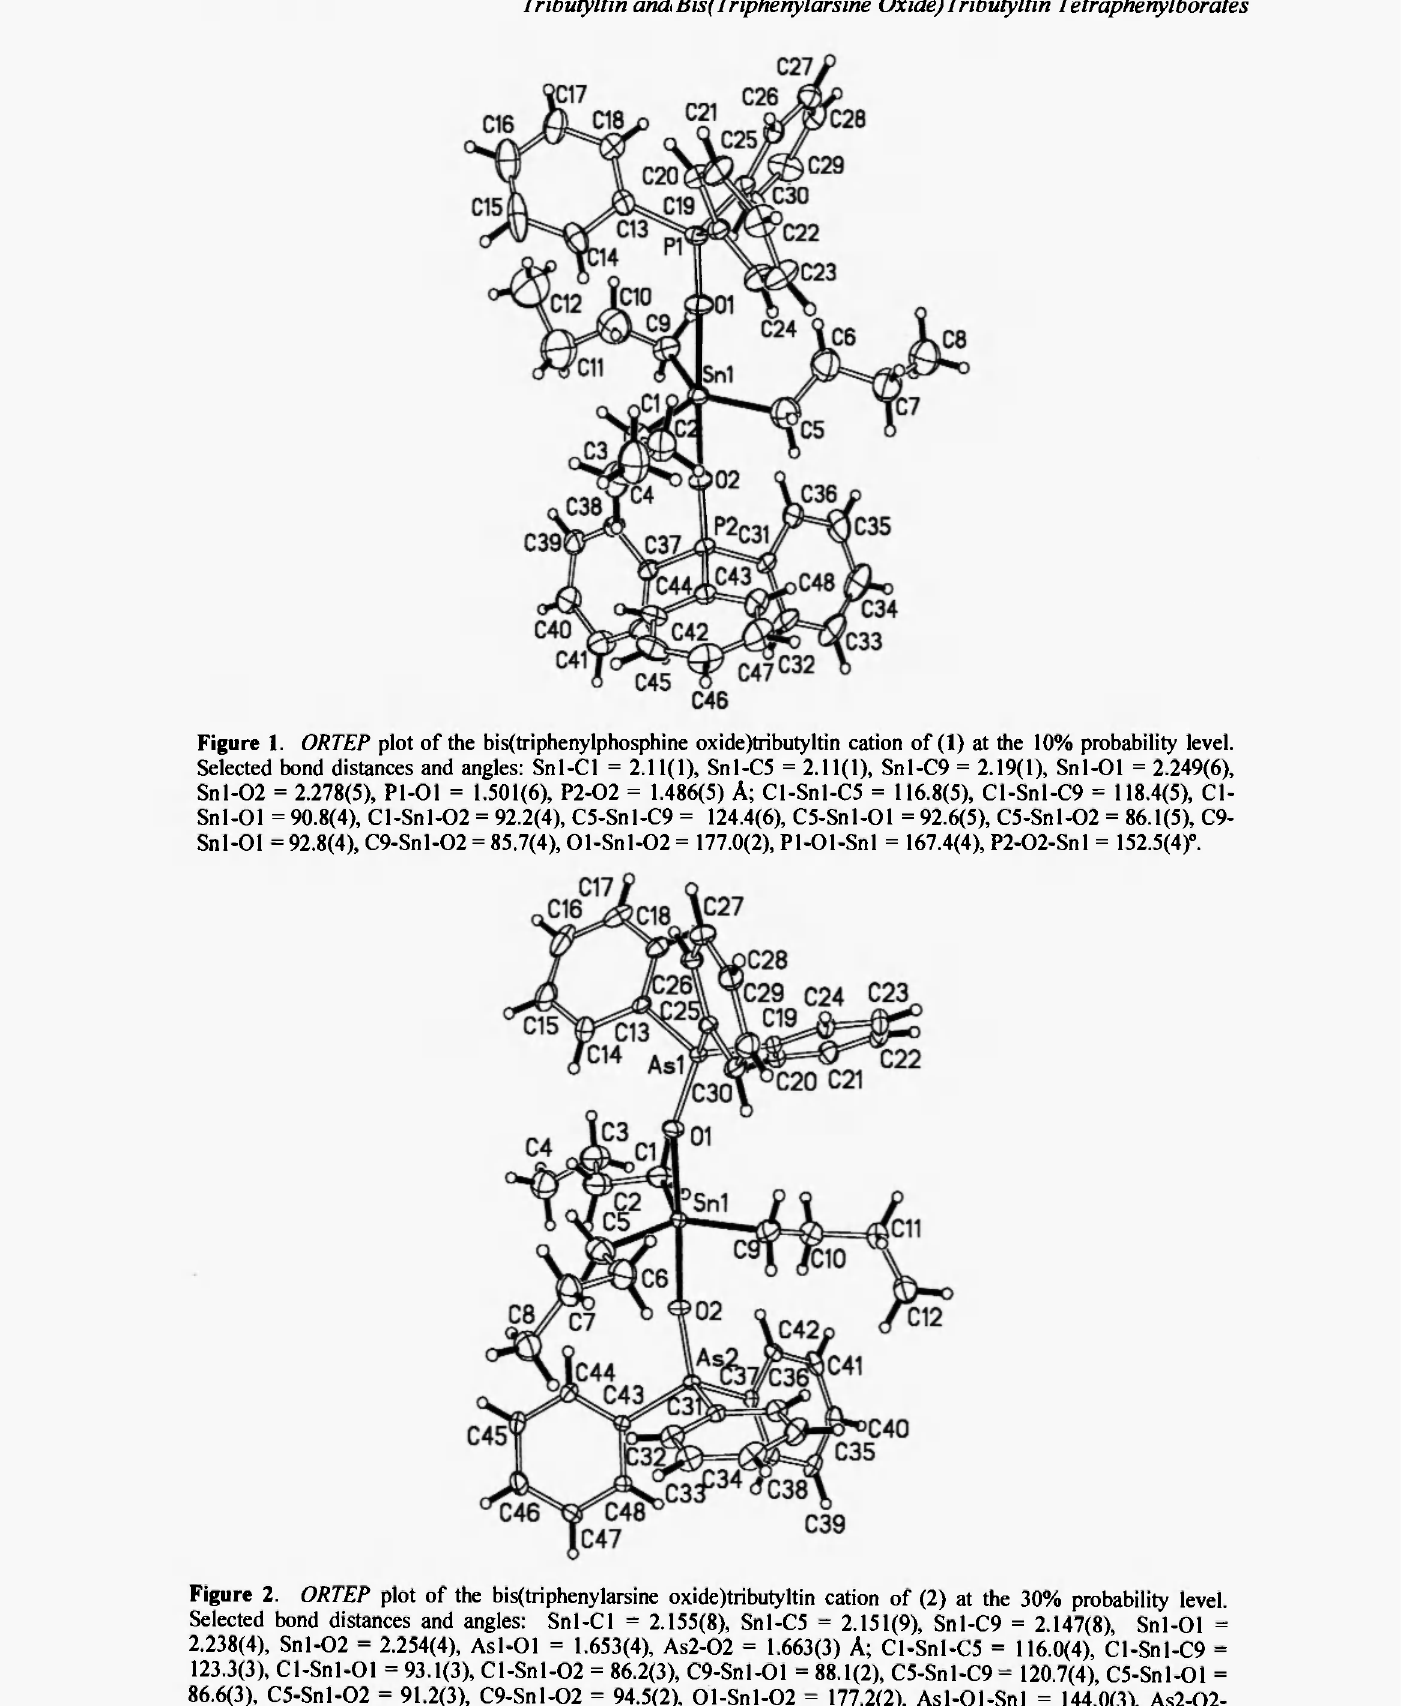
Figure 2. ORTEP plot of the bis(triphenylarsine oxide)tributyltin cation of (2) at the 30% probability level. Selected bond distances and angles: Snl-Cl = 2.155(8), Snl-C5 = 2.151(9), Snl-C9 = 2.147(8), Snl-Ol = 2.238(4), Snl-02 = 2.254(4), Asl-Ol = 1.653(4), As2-02 = 1.663(3) A; Cl-Snl-C5 = 116.0(4), Cl-Snl-C9 = 123.3(3), Cl-Snl-Ol = 93.1(3), Cl-Snl-02 = 86.2(3), C9-Snl-01 = 88.1(2), C5-Snl-C9 = 120.7(4), C5-Snl-01